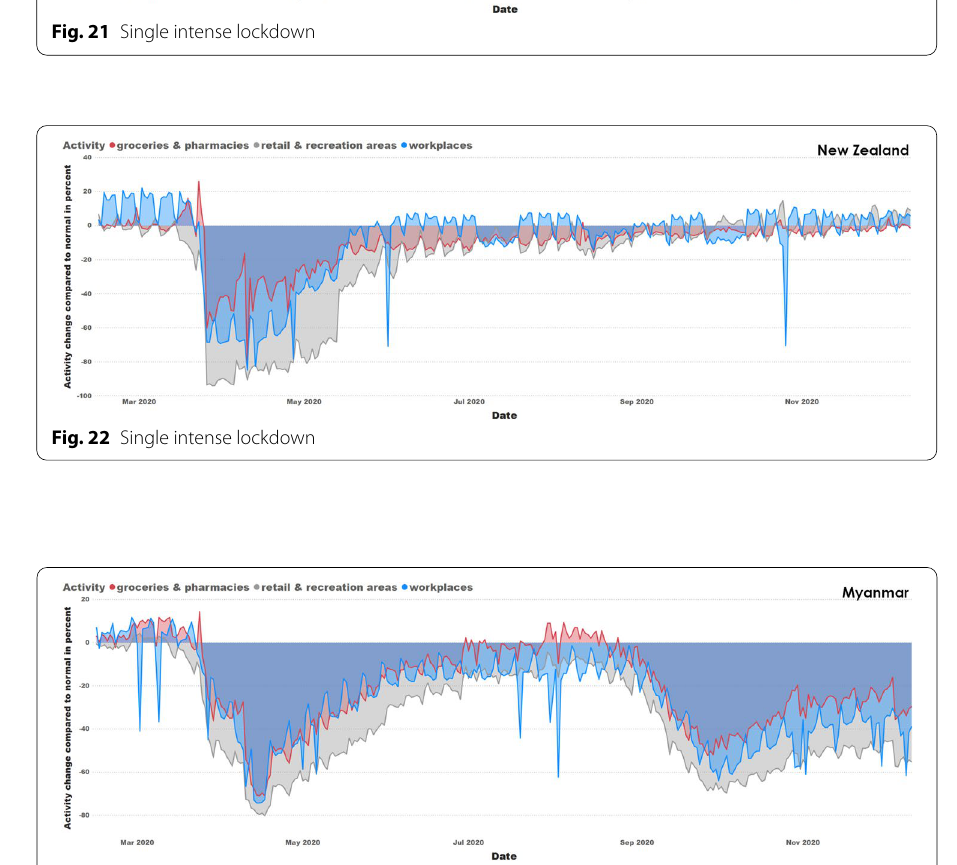
Fig. 23 Two intense